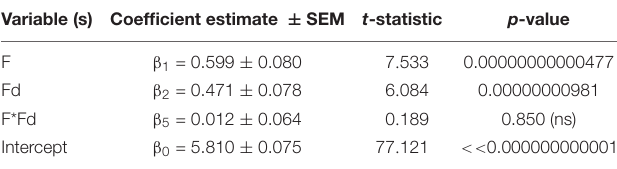
TABLE 2 | Reduced regression model of interest rating (I) as a function of number of fixations (F) and fixation duration (Fd) I = β 0 + β 1 *F + β 2 *Fd + β 3 *F*Fd. Variable (s) Coefficient estimate ± SEM t -statistic